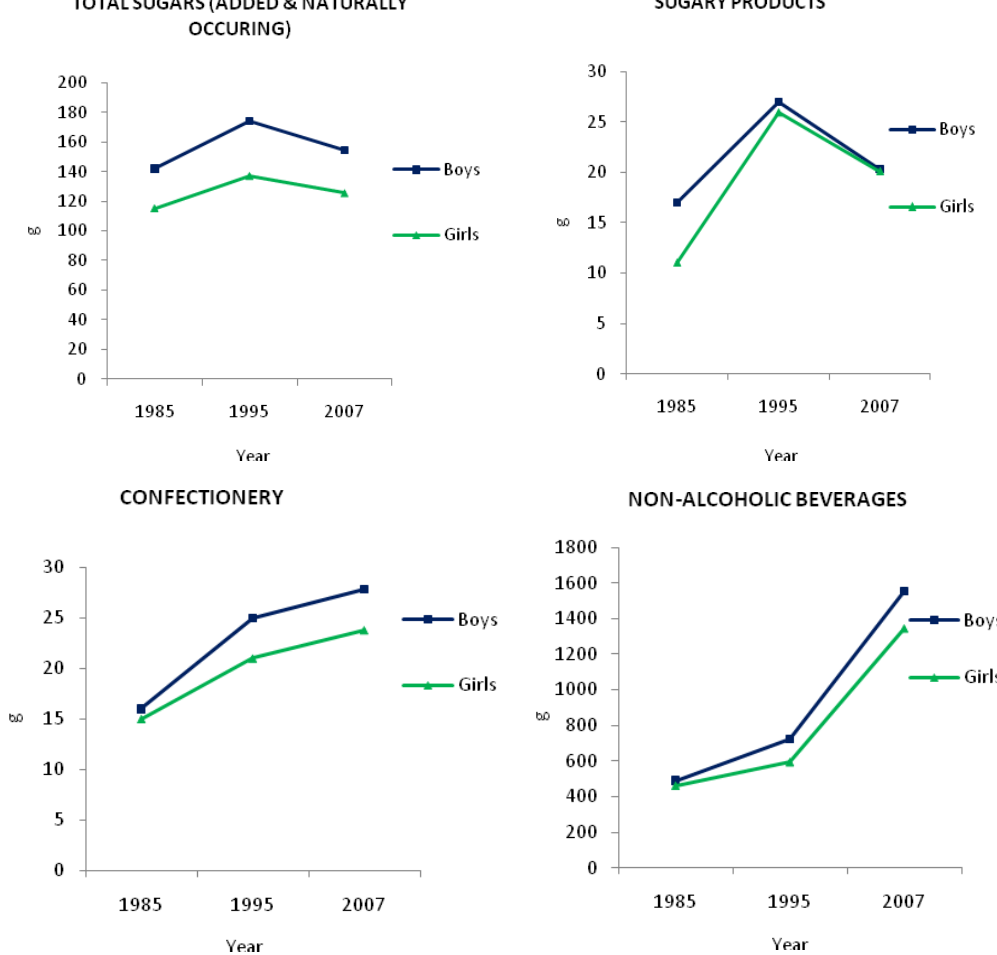
Figure 4. 24 h mean intake (g) of total sugars, sugary products, confectionery and non-alcoholic beverages * by Australian children in 1985, 1995 and 2007 [5,19]. Note: the age categories used for comparison where 10–15 year old children in years 1985 and 1995, the 2007 figure is an average between intakes of 9–13 year and 14–16 year